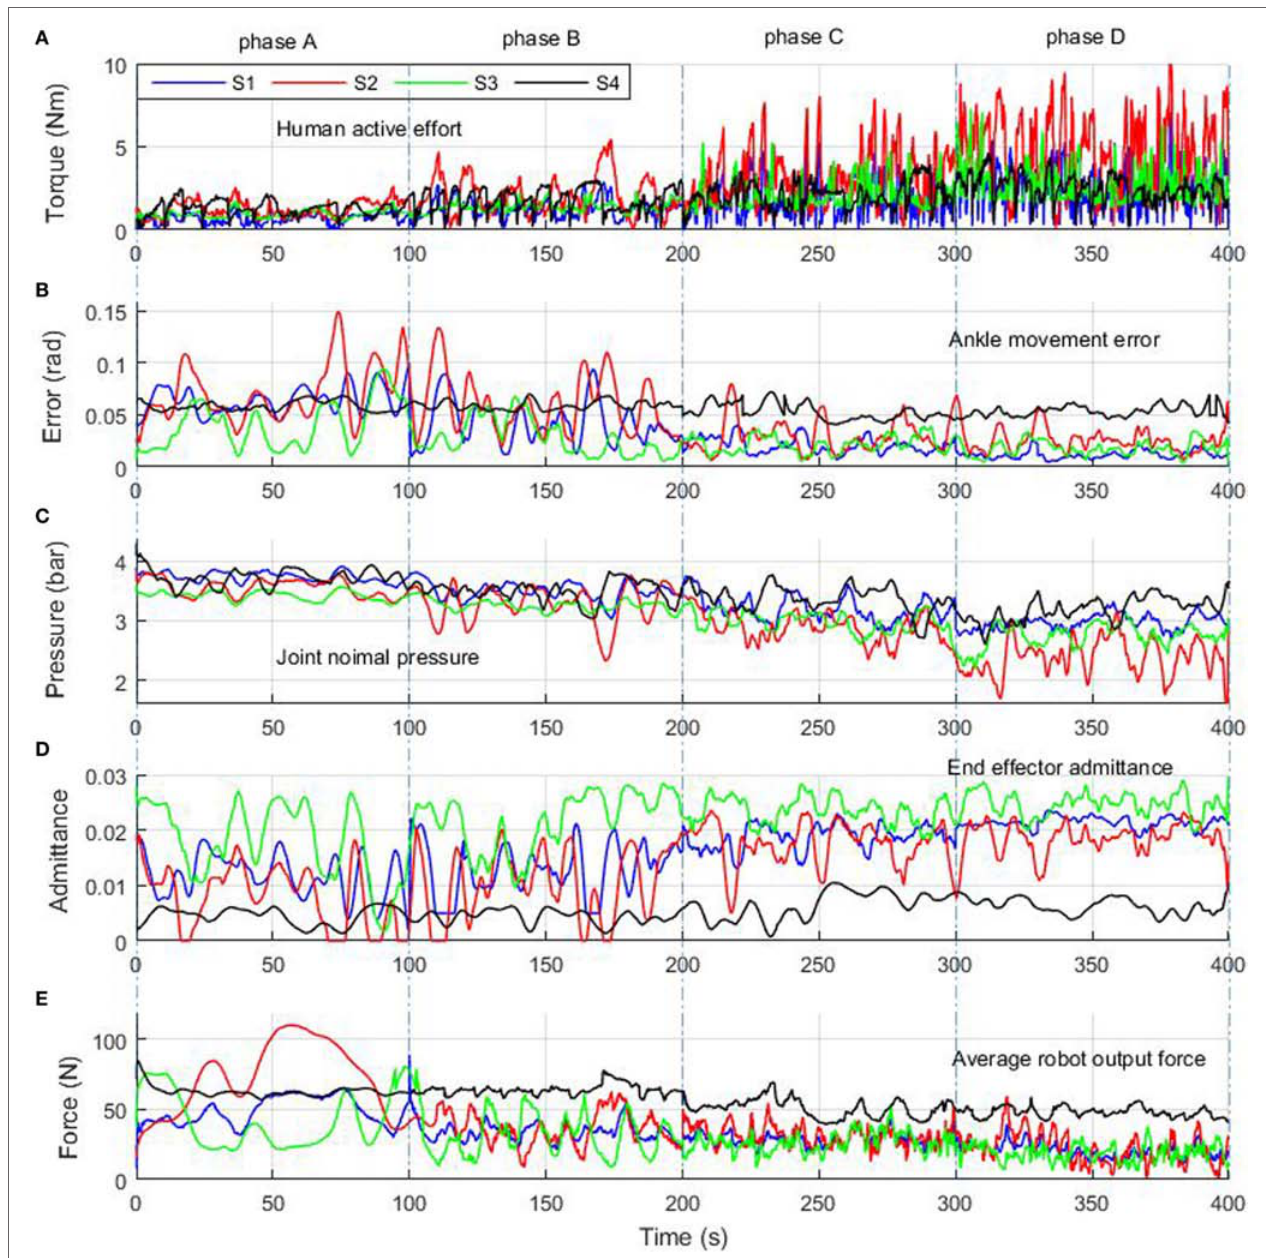
FIGURE 12 | Experiment results of adaptive hierarchical compliance control with four human subjects who were asked to increase active contribution each time from phase A to phase D. Human active effort (A) was calculated using Eq. 20, ankle movement error (B) was obtained from using Eq. 22, joint nominal pressure (C) was regulated based on human participation by Eq. 19, end-effector admittance (D) was adjusted to human movement error (Eq. 21), and average robot force (E) was the mean value of four muscles’ pulling forces. Blue, red, green, and dark lines represent the results of S1, S2, S3, and S4, respectively.